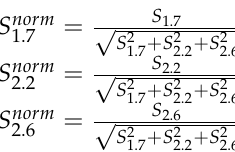
Figure 9. Confusion matrix for the classification of HDPE (class 0) and PP (class 1).